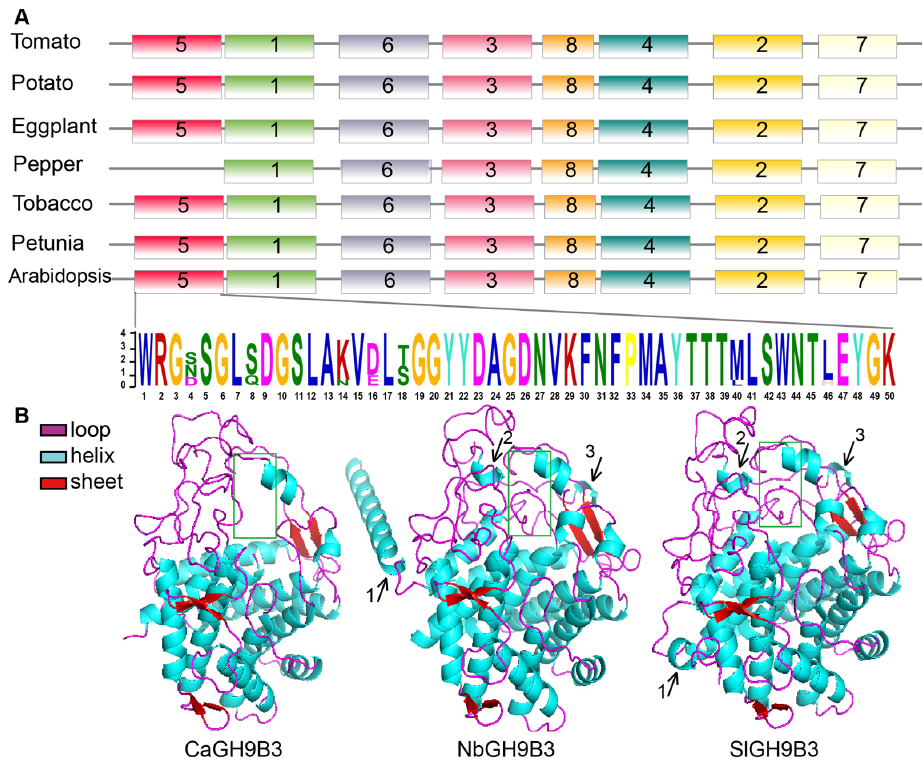
Figure 4. Motif arrangement and protein structure of GH9B3 members. ( A ) Motif 5 is missing in pepper GH9B3. Motif discovery was conducted through the MEME website and seven motifs were detected. ( B ) Protein structure of CaGH9B3, NbGH9B3 and SlGH9B3. The protein structure was predicted through RoseTTAFold. Purple, blue and red cartoons represent loop, helix and sheet structure, respectively. The black arrows (1, 2 and 3) point out the difference of helix structure, and the green rectangle emphasizes the difference of the loop structure from CaGH9B3.